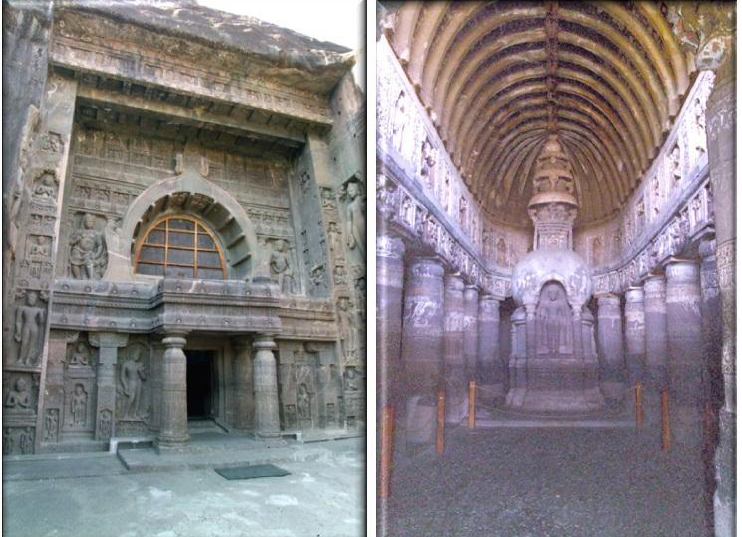
Figure 6. Outer and Inner view of cave 19, Ajanta: for its alignment to winter solstices external part was little curved and inner part also altered.